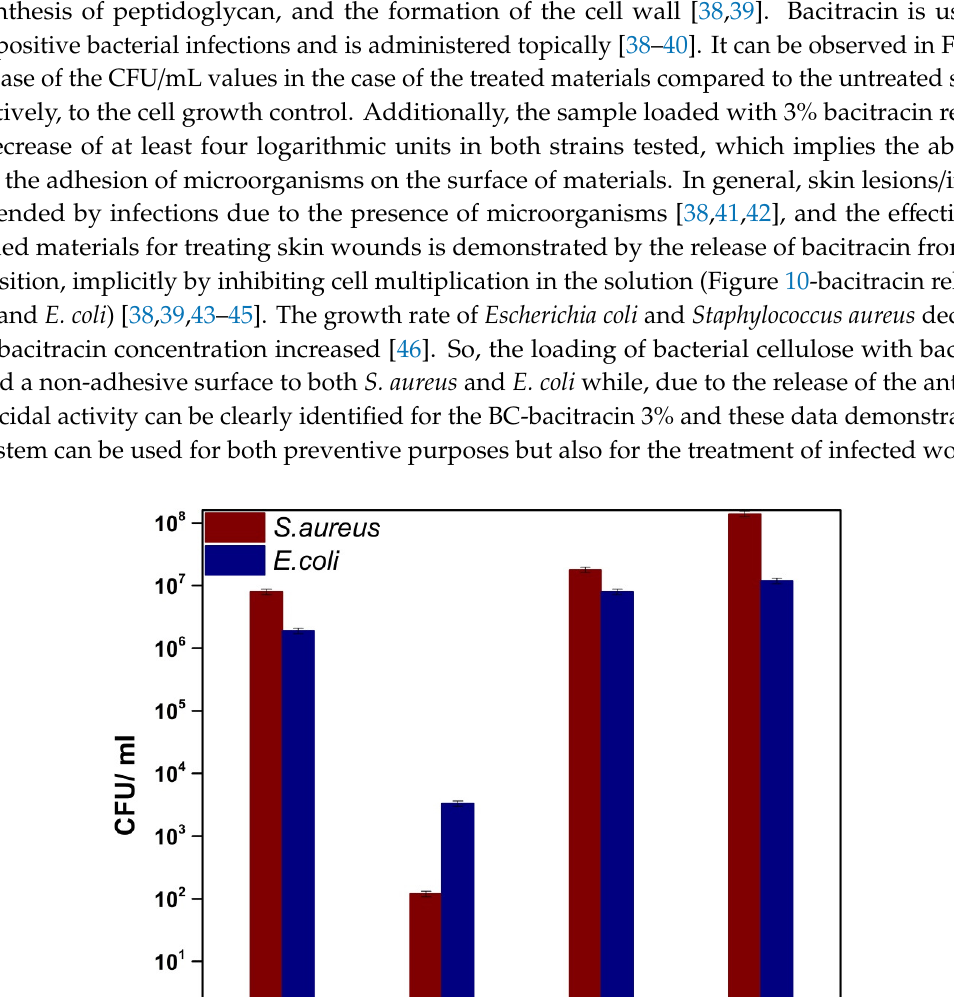
Figure 10. Graphical representation of CFU/mL values of Staphylococcus aureus ATCC 25923 and Escherichia coli ATCC 25922, in order to evaluate the bacitracin release from the BC-bacitracin samples into the broth media.